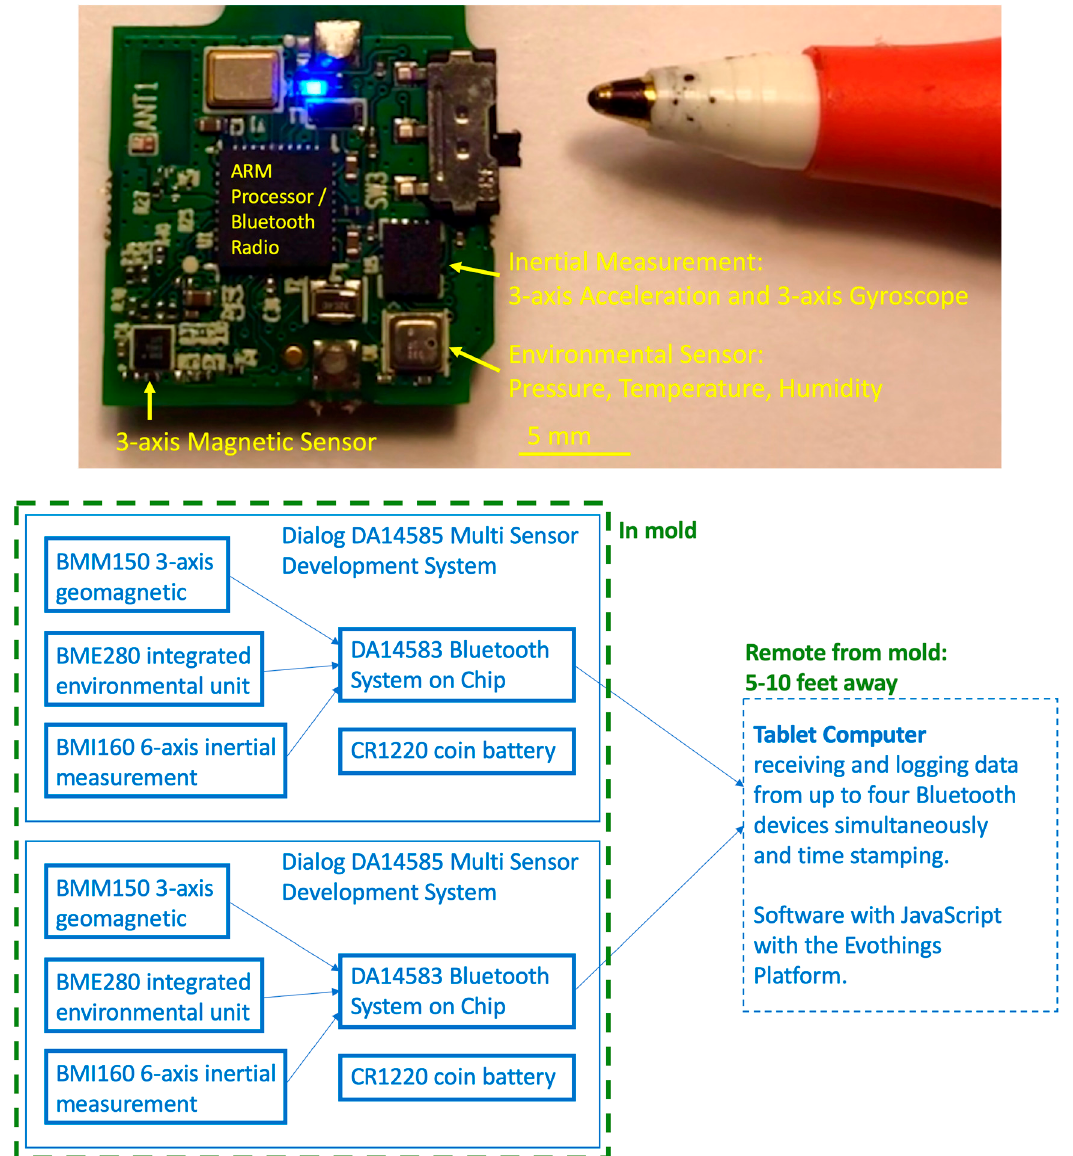
Figure 6. ( Top ) Components of Dialog DA14585 IoT sensor system [25]; ( Bottom ) Block diagram of data acquisition.